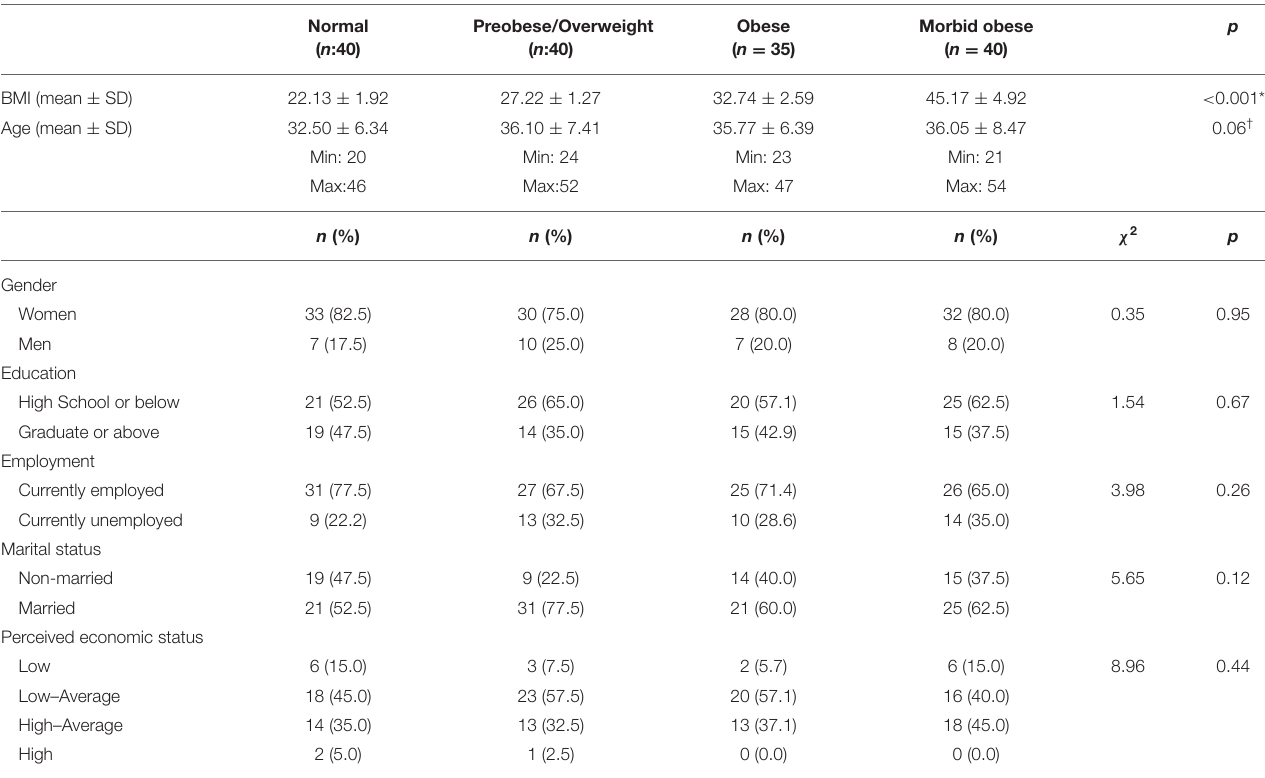
TABLE 1 | Mean BMI and sociodemographic characteristics of participants.